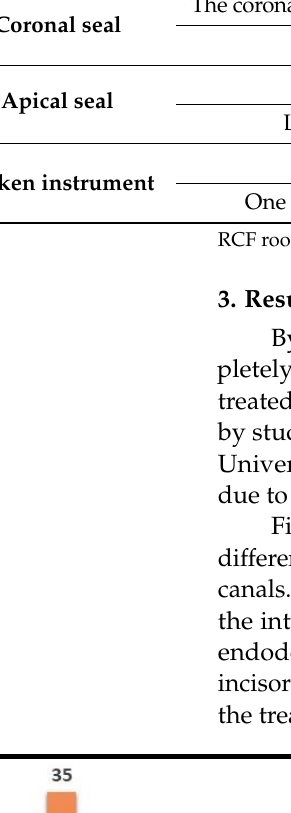
Figure 2. Number of endodontic treatments performed (root canal-wise) by students of different academic levels.